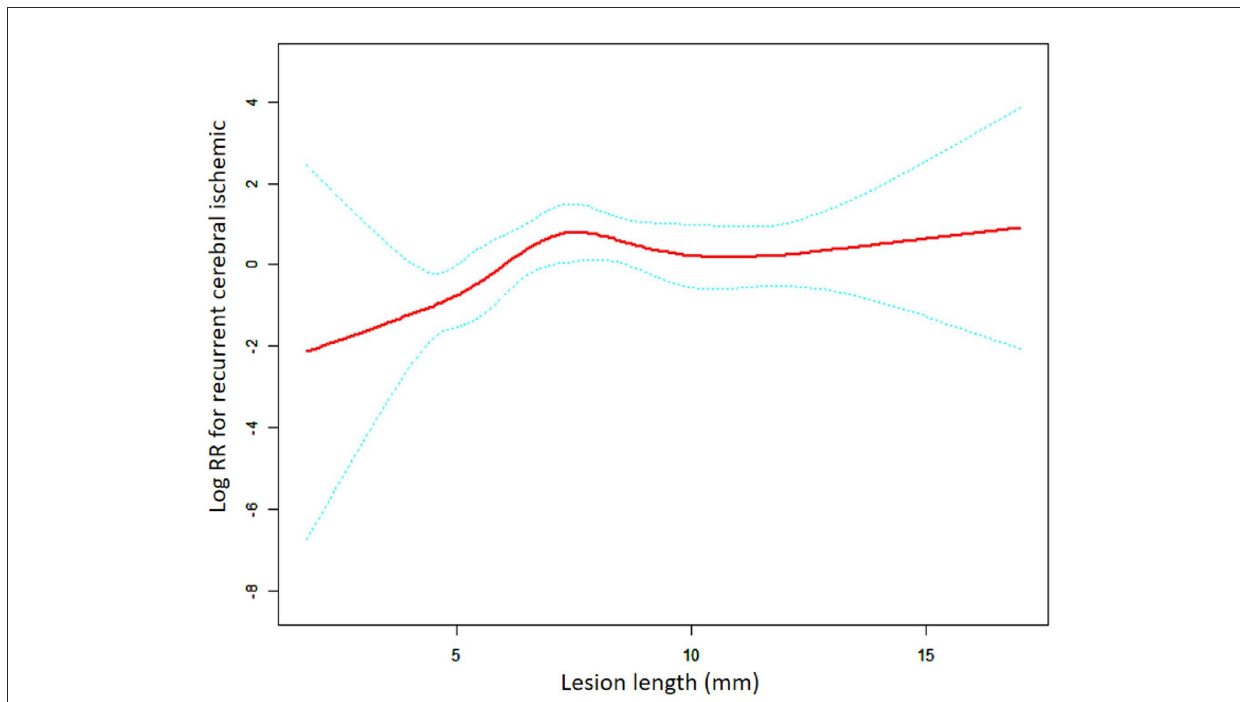
FIGURE1 A non-linear association between lesion length and recurrent cerebral ischemic in the overall group. The red solid line indicates the smooth curve fit between lesion length and RCI. The blue dotted line represents the 95% confidence interval of the fit (RR, relative risk).